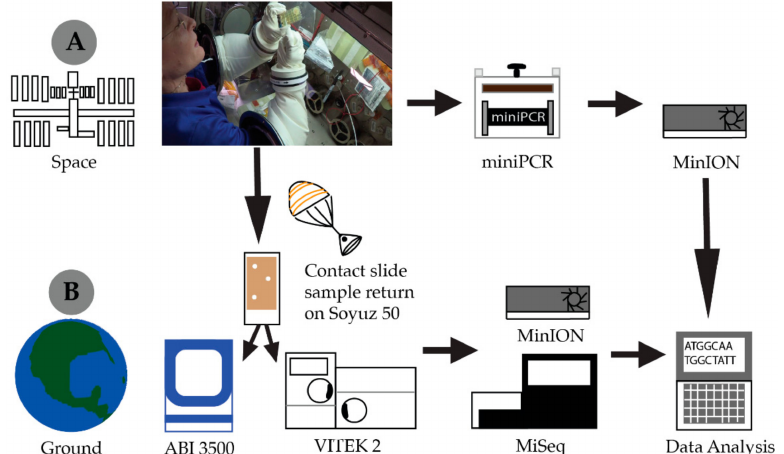
Figure 2. Workflow of the first on orbit sequencing library preparation and in situ sequencing of bacterial colonies cultured from the International Space Station performed by astronaut Dr. Peggy Whitson on 21 August 2017. ( A ). Whitson selected three bacterial colonies from a surface sample kit slide for colony PCR amplification. Amplified DNA was cleaned up with Exonuclease 1 enzyme and prepared for sequencing with Rapid 16S sequencing kit (RAS201 ONT). After 48 h of sequencing, data were downlinked to Earth for analysis. ( B ). The bacterial culture was returned to Earth on Soyuz 50 and transported to the Johnson Space Center Microbiology Lab for routine biochemical and Sanger sequencing analysis, as well as additional Nanopore and MiSeq